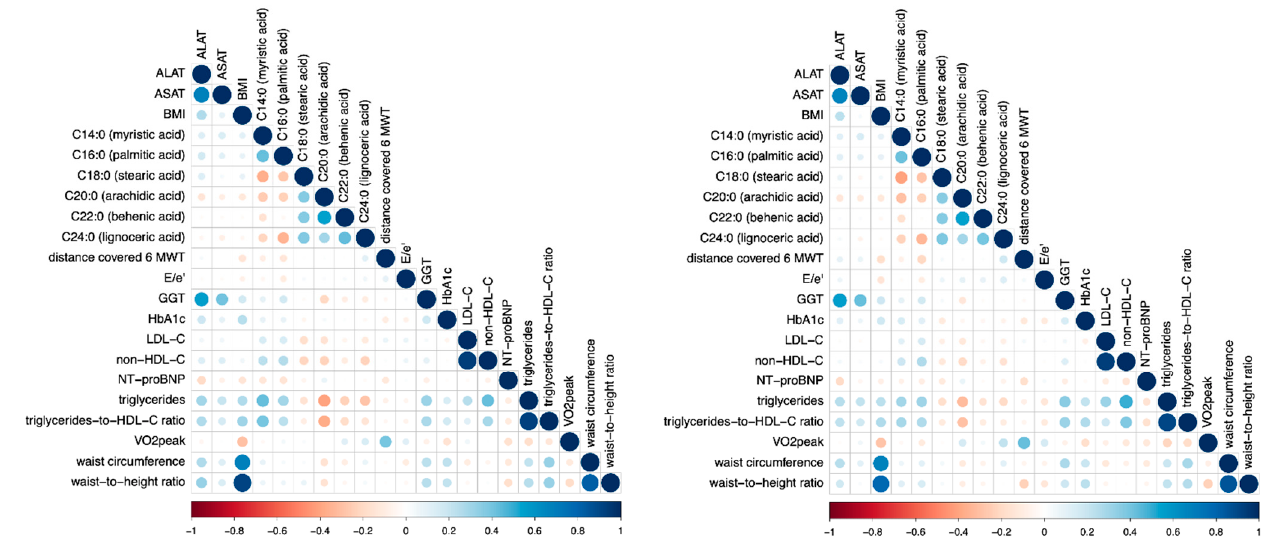
Figure 1. Correlation plot showing correlations between individual SFA and patient characteristics at baseline ( left ) and after 12-month follow-up ( right ). Blue color indicates a positive association; orange color indicates an inverse association. Higher color intensity and larger circles indicate a stronger association and lower color intensity, while smaller circles indicate a weaker association.